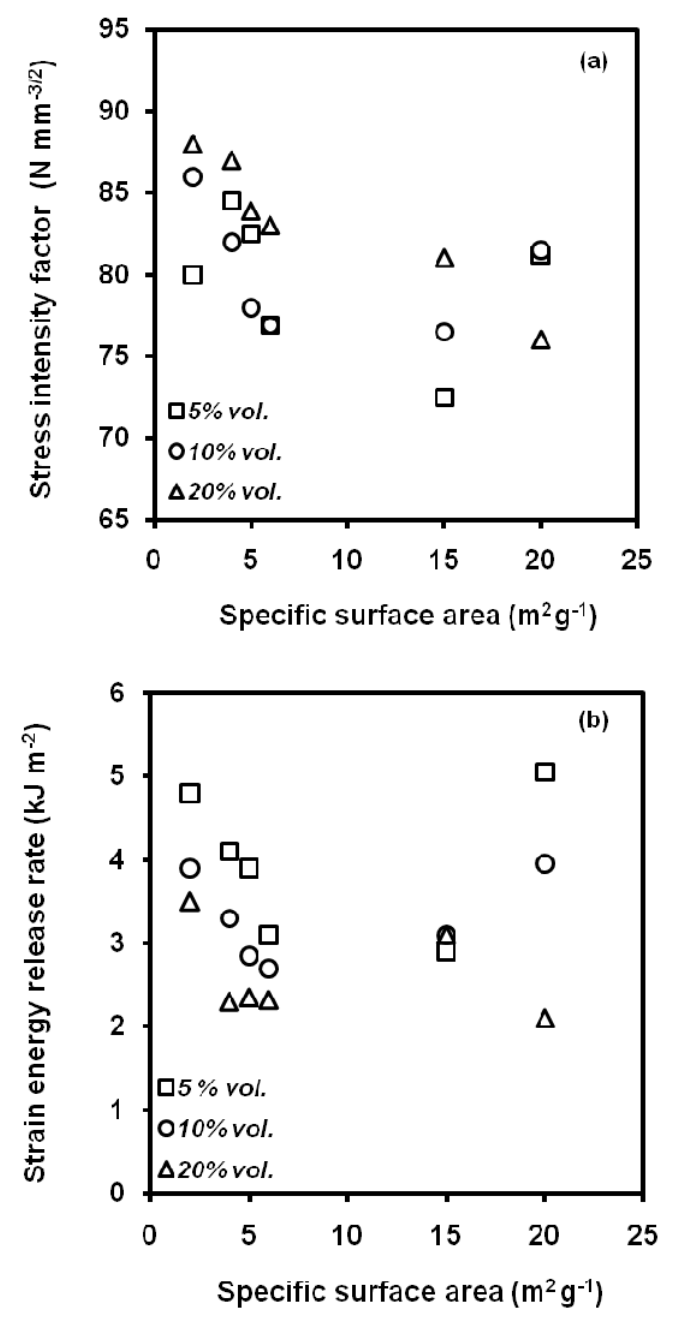
Figure 23. Influence of the specific surface area of CaCO stress intensity factor, K composites (adapted from